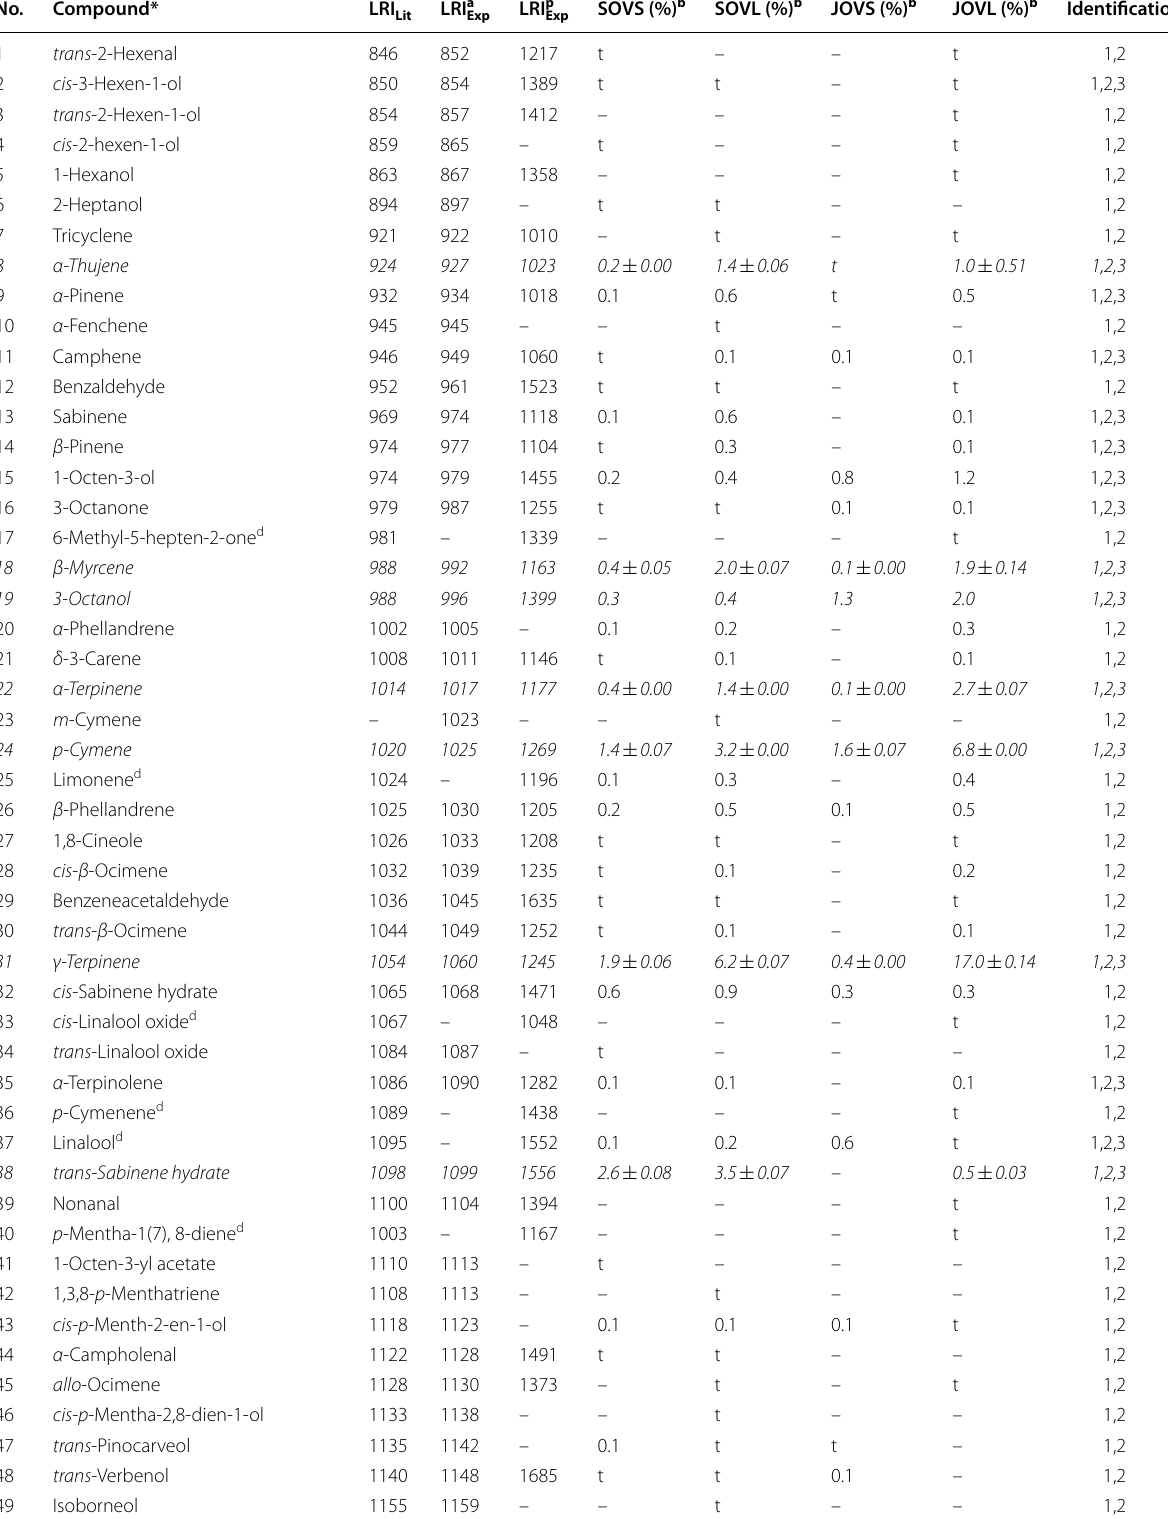
Table 1 Chemical constituents of leaf and stem volatile oils of O. vulgare L. grown in Saudi Arabia and Jordan